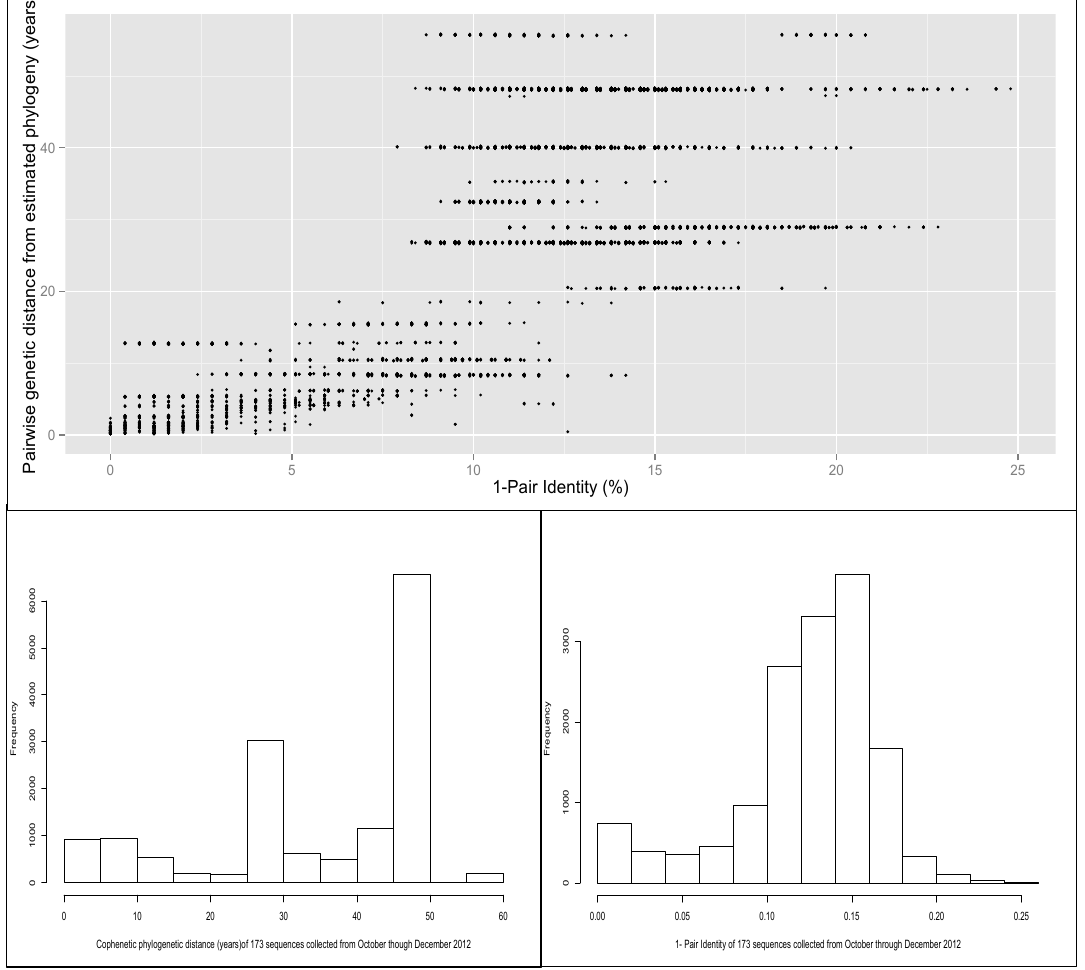
Figure 3. ( A ) Scatter plot of pairwise genetic identity and the distance computed from the phylogenetic tree. The total number of pairs of the 173 sequences was 14,878. Pearson’s correlation was 0.70 (95%CI 0.71-0.69). ( B ) and ( C ) Histograms of distribution of pairwise identity and tree cophenetic distance values between pairs of